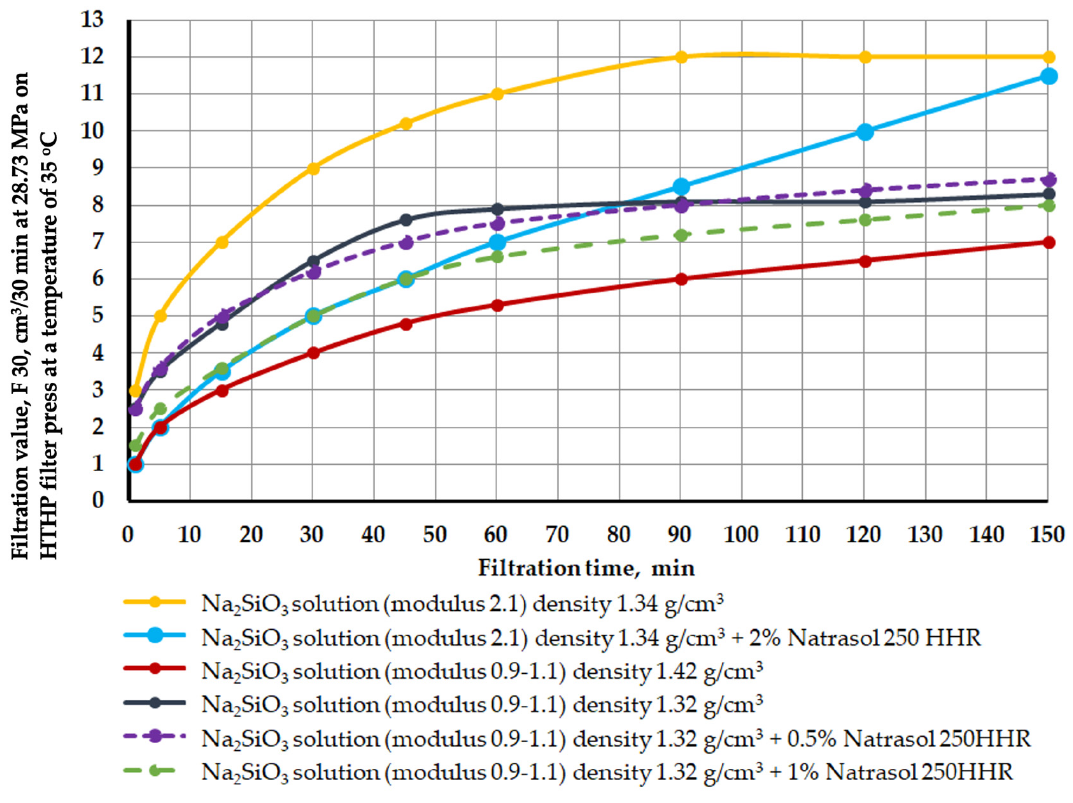
Figure 9. Filtration change over time in brine crosslinkers as a function of silicate modulus, density, and hydroxyethyl cellulose content Natrosol 250HHR at 35°C and 28.73 MPa.